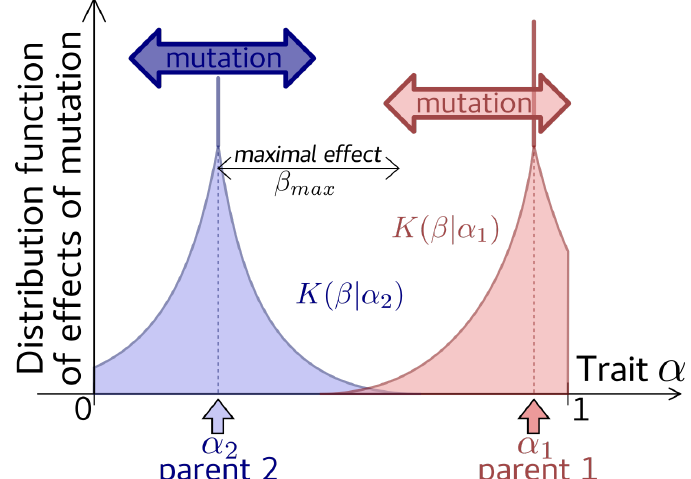
Figure SI.3. Distribution of mutational effects K ( β | α ) . Each parent of trait, e.g. α 1 or α 2 , produce offspring with trait α i + β where β has the density K ( β | α i ) depending on its parent traits (red and blue curves for α 1 and α 2 , respectively).